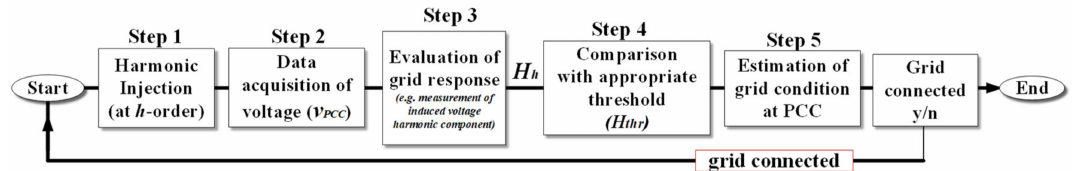
Figure 1. Generic description of the harmonic injection based anti-islanding